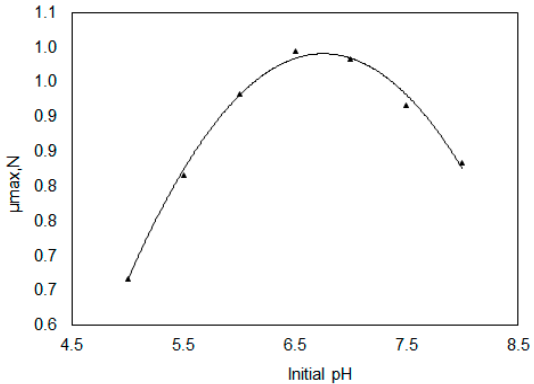
Figure 2. Variation of µ max.N with respect to initial pH. Table 5. Values of kinetic parameters.